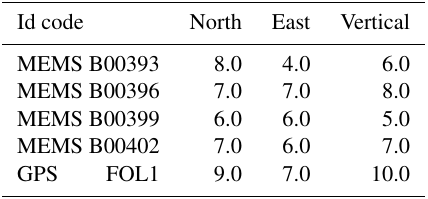
Table 3. Root Mean Square (RMS) values of the HRGPS and MEMS time series estimated using the data available from 90s be- fore and 10s after the main UTC time of the event, during quite ac- quisition time. The GPS and MEMS values are respectively inmm and ms − 2 . The columns reported the values estimated analysing the time series of the North, East and Vertical